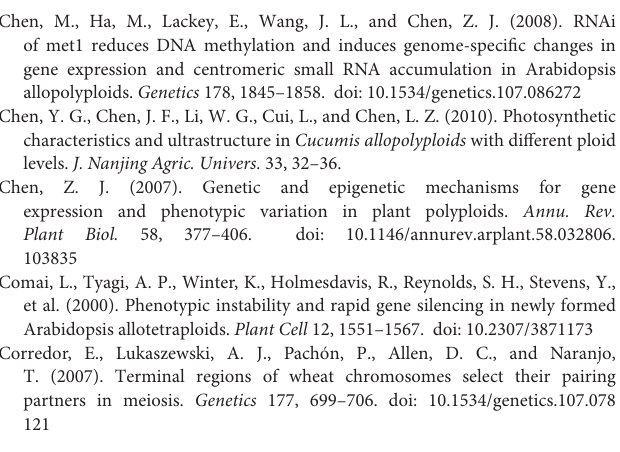
Supplementary Table 1 | Novel genes in Carassius auratus (RCC) and autotetraploid Carassius auratus (4nRR). Supplementary Table 2 | AFLP and MSAP adapters and primers that were utilized in this